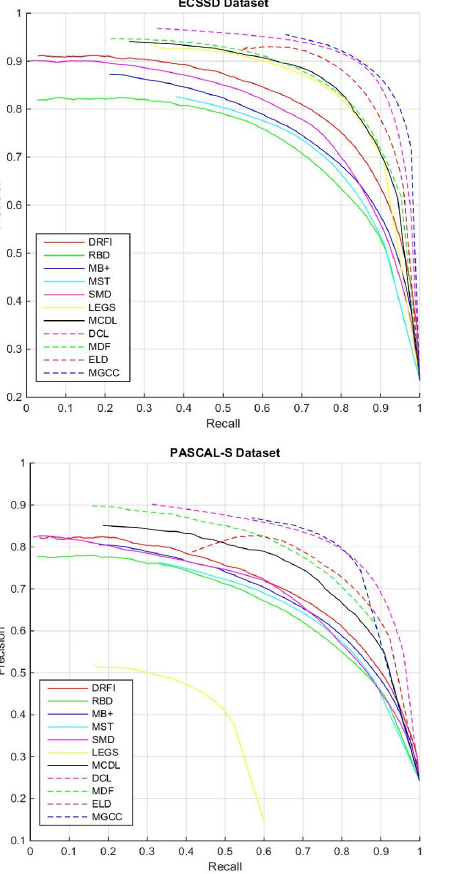
Figure 4. P-R curves of the proposed and 10 state-of-the-art methods on ECSSD, HKU-IS, PASCAL-S and DUT-OMRON